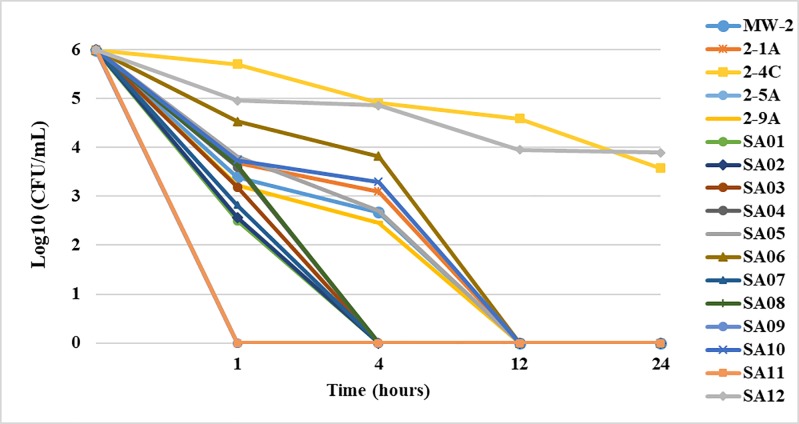
Bactericidal activity of PAAG against seventeen MRSA clinical isolates.PAAG at a concentration of 100 μg/mL was added at timepoint 0 and monitored until 24h. Six log reductions in CFU/mL were observed in 58% of the MRSA isolates tested in 1-4h of treatment. 88% of the MRSA strains was observed within 12h of PAAG treatment. Data is presented as mean ± SD (n = 3).